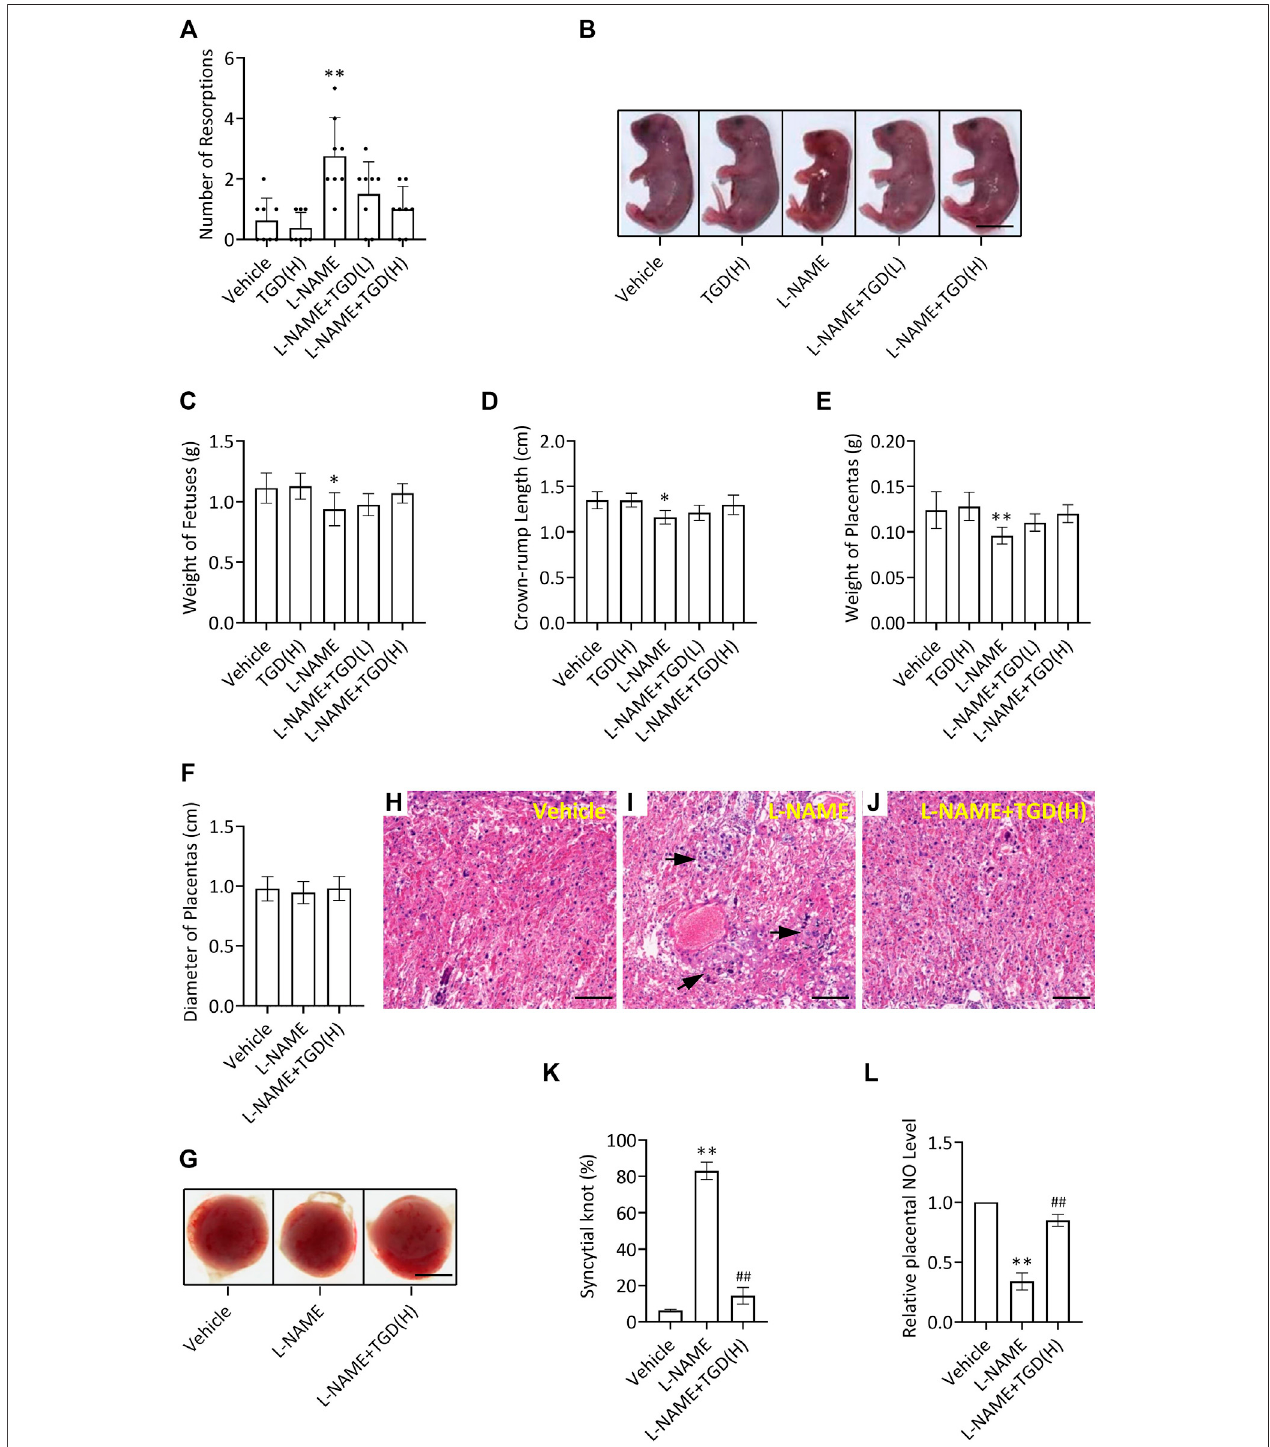
FIGURE5 | TGDrestores pregnancy outcomein a PEmouse model. (A) Number ofresorptions pregnant mice administrated withor without L-NAME and TGD at low dose (L, 20 g/kg/d) or high dose (H, 40 g/kg/d). (B) Representative pictures of fetuses from pregnant mice administrated with or without L-NAME and TGD at low dose (L, 20 g/kg/d) or high dose (H, 40 g/kg/d). Bar, 0.6 cm. (C) Weight of fetuses from pregnant mice administrated with or without L-NAME and TGD at low dose (L, 20 g/kg/d) or high dose (H, 40 g/kg/d). (D) Crown-rump length of fetuses from pregnant mice administrated with or without L-NAME and TGD at low dose (L, 20 g/kg/d) or high dose (H, 40 g/kg/d). (E) Weight of placentas from pregnant mice administrated with or without L-NAME and TGD at low dose (L, 20 g/kg/d) or high